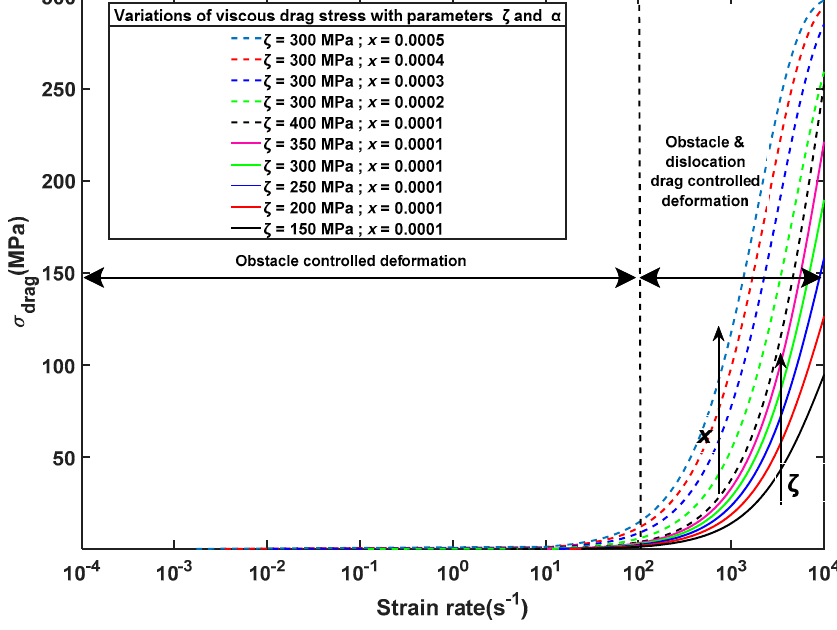
Figure 9. The viscous drag stress component against strain rate at various values of the curve-fitting parameters 𝜁 and χ . parameters ζ and χ